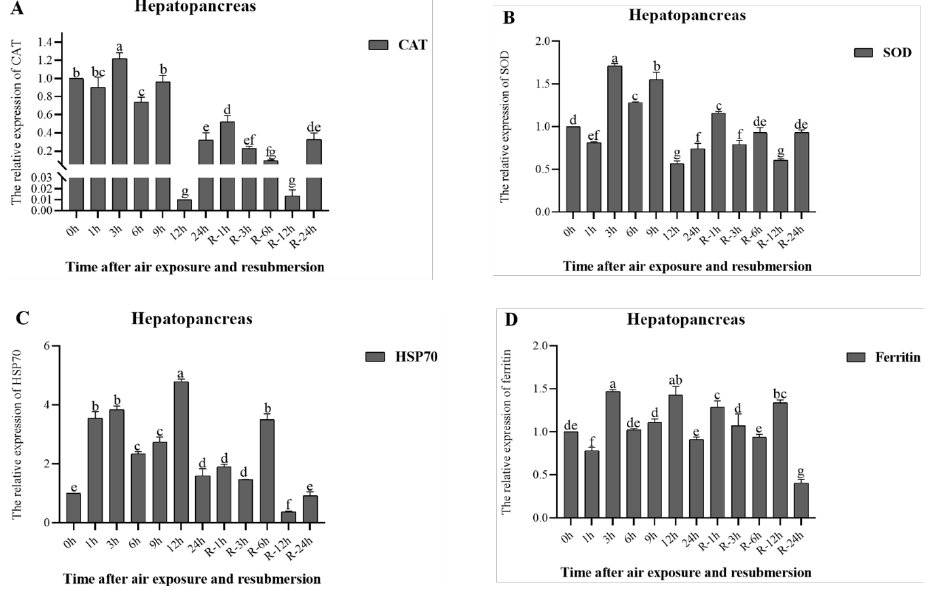
Figure 5. Relative expression levels of CAT ( A ), SOD ( B ), HSP70 ( C ), and Ferritin ( D ) in the hepatopancreas of P. clarkii after air exposure for 0 h, 1 h, 3 h, 6 h, 9 h, 12 h, and 24 h, including re-submersion for R-1 h, R-3 h, R-6 h, R-12 h, and R-24 h. Different letters represent significant differences between various exposure times ( p < 0.05).